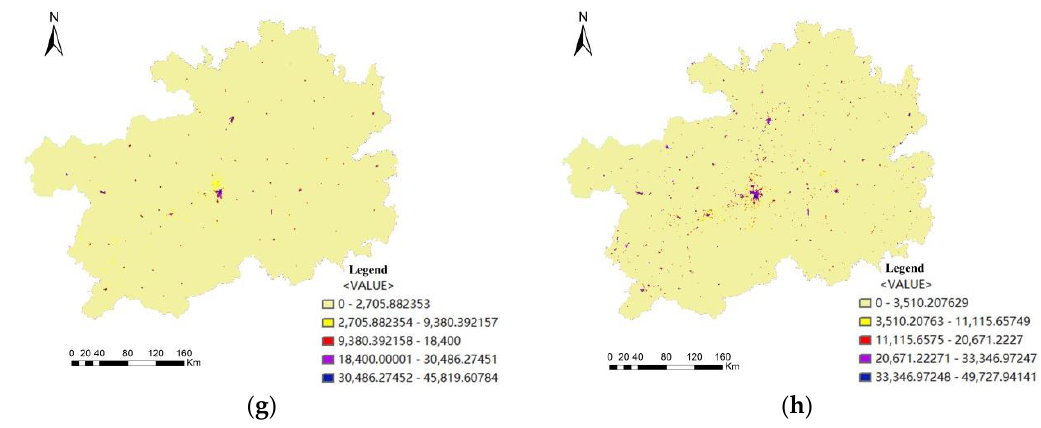
Figure 2. Spatial distributions of eight indices: ( a ) u1 , annual average rainfall (0.1 mm); ( b ) u2 , annual maximum 6-h heavy rainfall (mm); ( c ) u3 , annual maximum 60-min heavy rainfall (mm); ( d ) u4 , river network density (m/km 2 ); ( e ) u5 , vegetation index; ( f ) u6 , topographic relief (m); ( g ) u7 , population density (person/km 2 ); and ( h ) u8 , GDP density (10,000 RMB (Chinese yuan)/km 2 ).